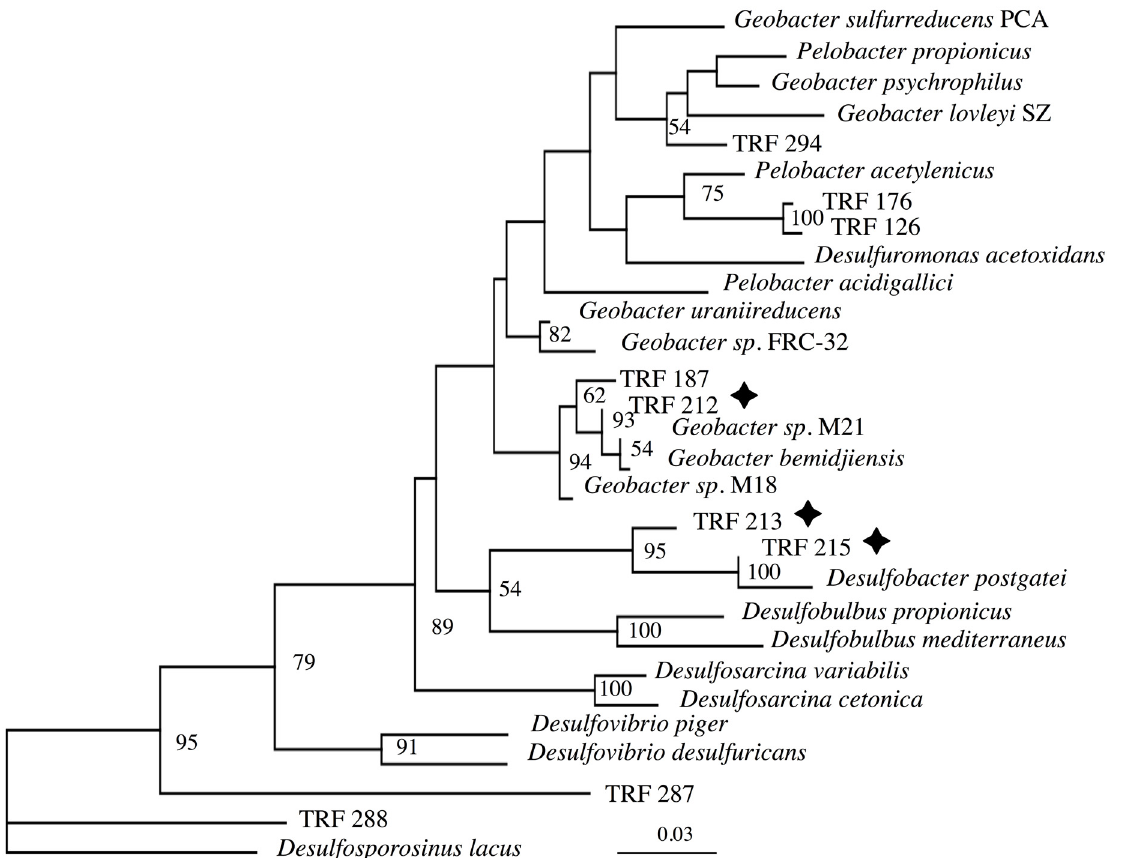
Fig 4. Phylogenetic tree of active TRF ’ s resulting from the uranium additions (star) are shown with the nearest cultured relatives. The reconstruction was done using maximum likelihood methods on 438 aligned bases. Bootstrap values > 50 for 100 iterations are